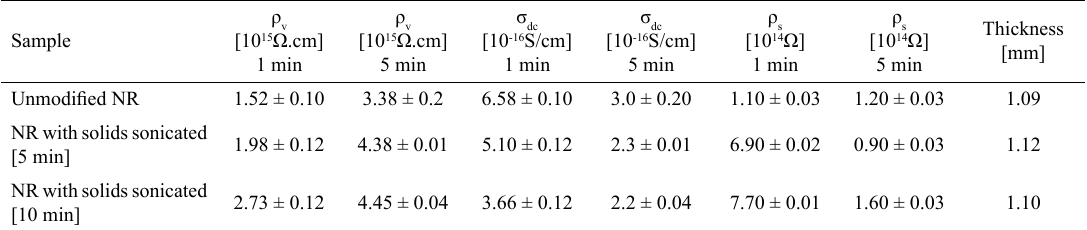
), surface resistivity (ρ v